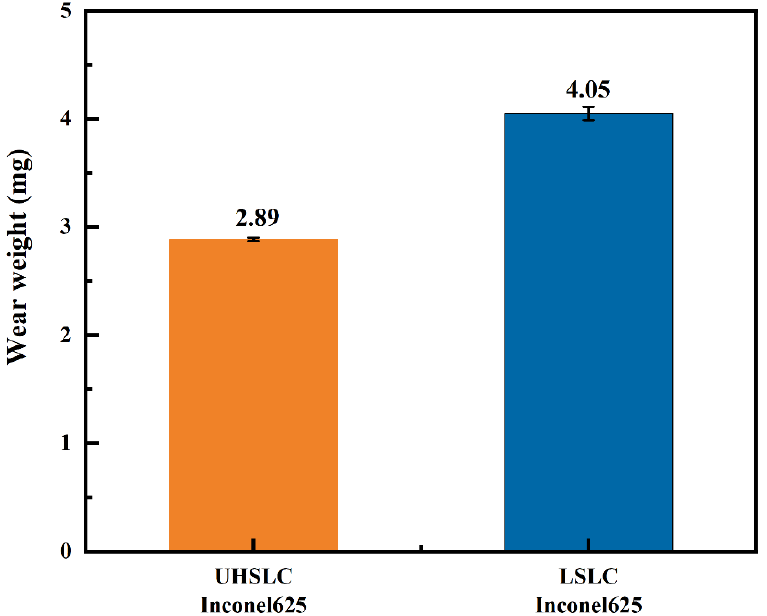
Table 3. Comparison of FWHM, grain size, dislocation density and micro-stress for different remelt- ing powers.